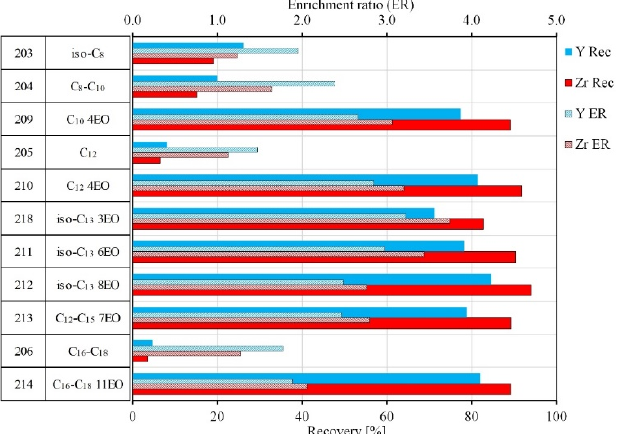
Figure 6. Results of collectors based on phosphoric acid esters.